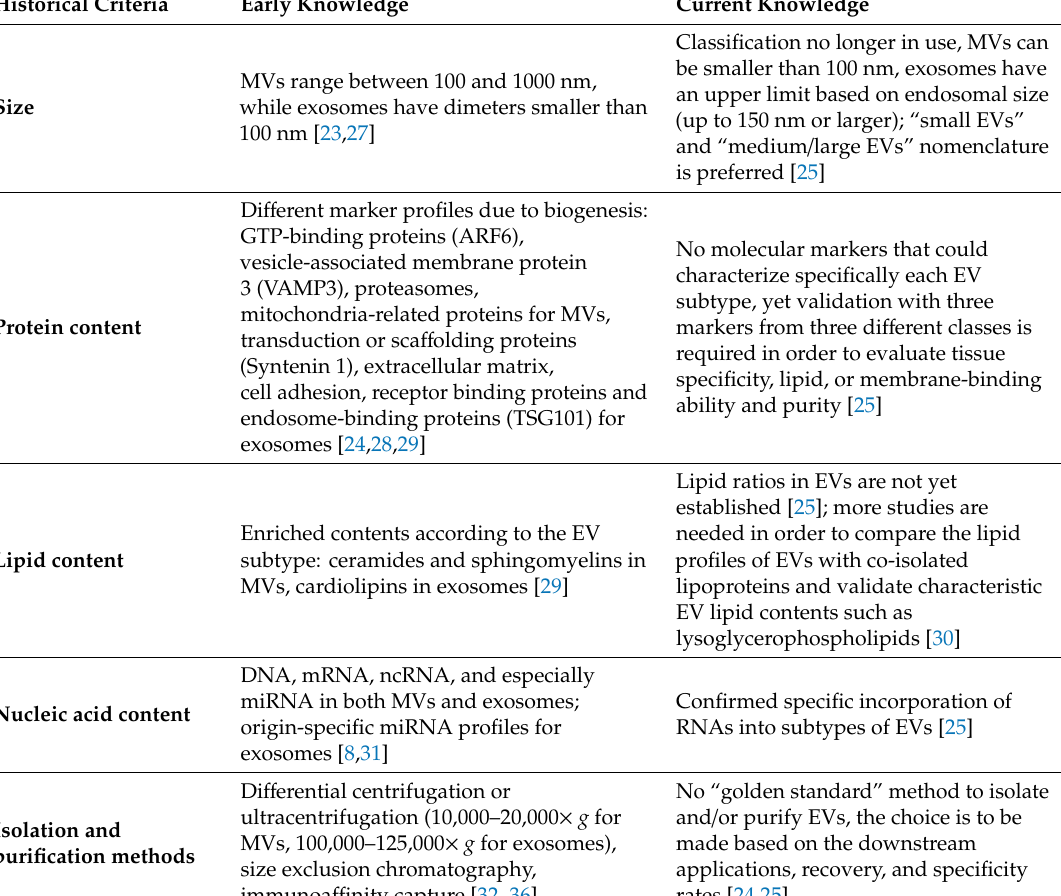
Evolution of extracellular vesicles (EV) dichotomous classification according to the accumulation of recent